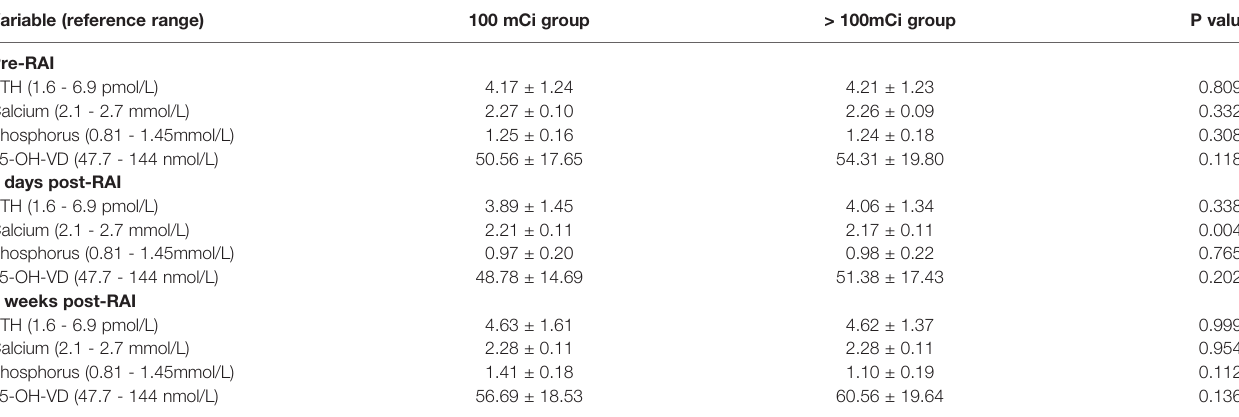
TABLE 3 | Comparison of PTH, serum calcium, phosphorus and 25-OH-VD values at pre-RAI and post-RAI between the 100 mCi group and larger 100 mCi group. Variable (reference